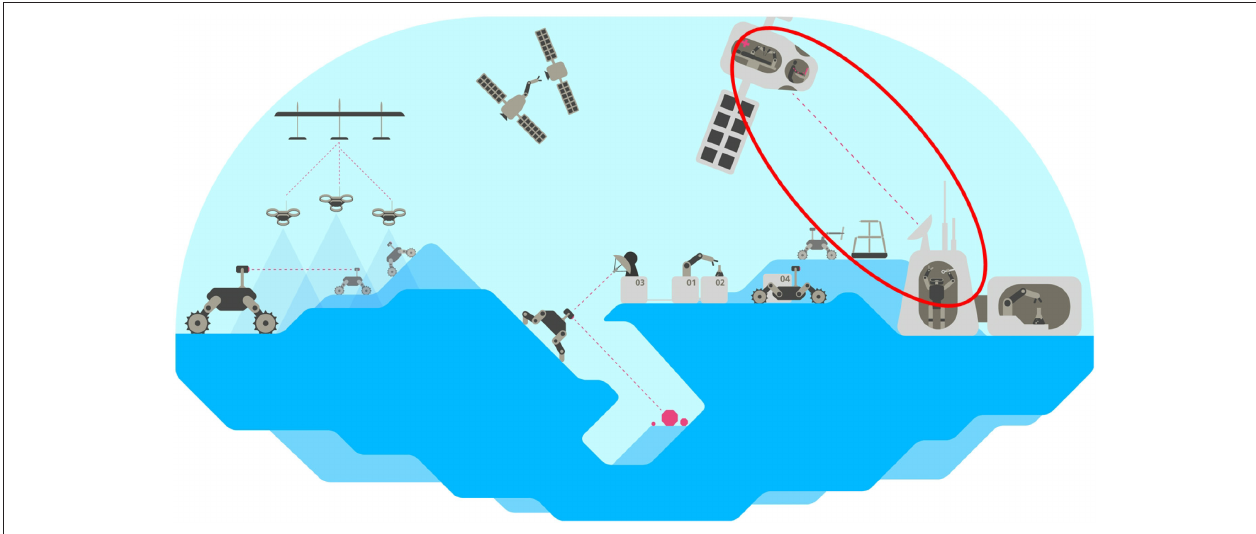
FIGURE 1 | Illustration of DLR’s space robot vision. Teleoperation is a key topic of DLR’s long-term research endeavors for robot applications on celestial bodies and is illustrated by the example of telemanipulation of a humanoid robot from a spacecraft. While the number of tasks that robots can perform autonomously is steadily increasing, teleoperation will still be required over the next few years or decades for situations where autonomy fails.